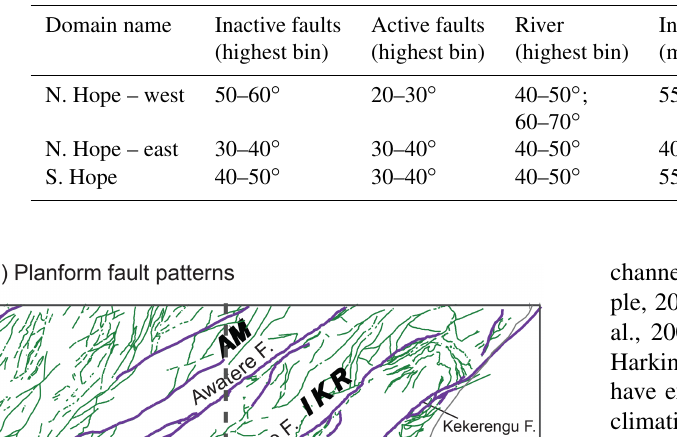
Table 1. Fault and river orientation results.